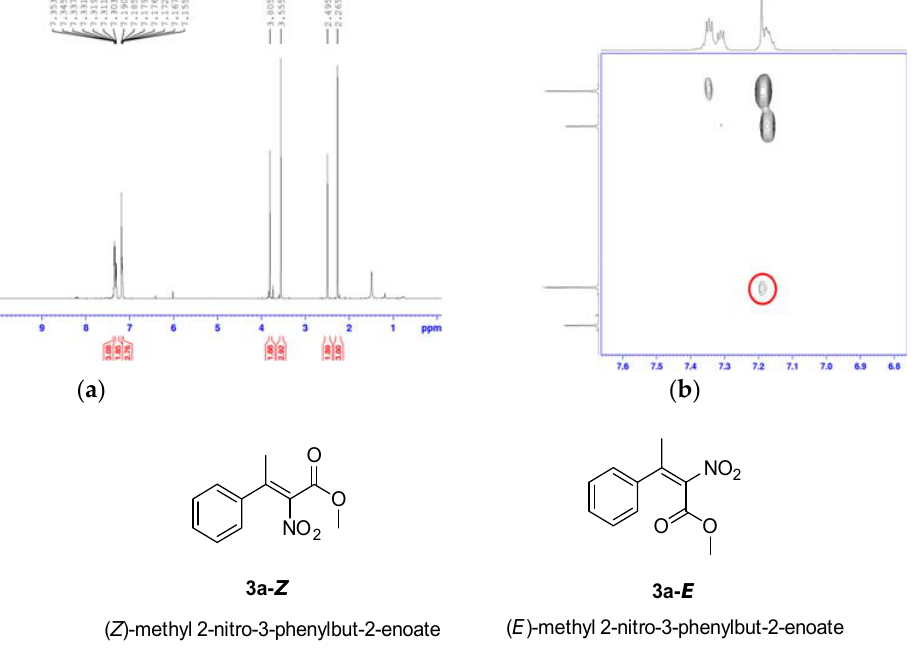
Figure 2. Further NMR experiments performed for tetrasubstituted nitroacrylate 3a. ( a ): NMR spectra of a mixture fraction of compound 3a . ( b ): NOE contact observed between OMe and Ph groups in the more abundant form of the tetrasubstituted nitroacrylate 3a . ( c ): structures of nitroacrylates 3a ‐ Z and 3a ‐ E .